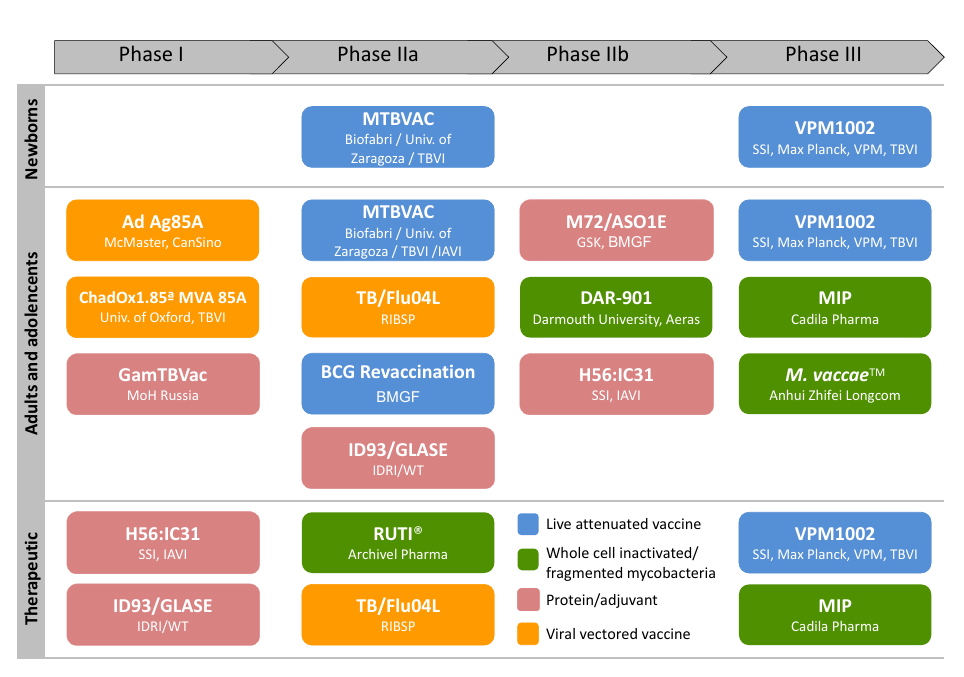
Figure 2. Tuberculosis (TB) vaccine candidates in the pipeline of clinical trials. The diagram shows the advance in clinical trials of the 14 vaccine candidates coloured according to each vaccine strategy.